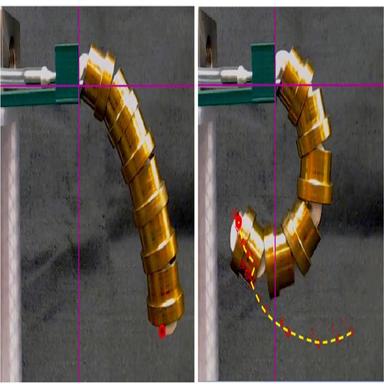
Dynamic displacement analysis under 10 psi, 0.5 Hz, and fully loaded condition. The trajectory of the tip of the actuator is described by the yellow dotted line.